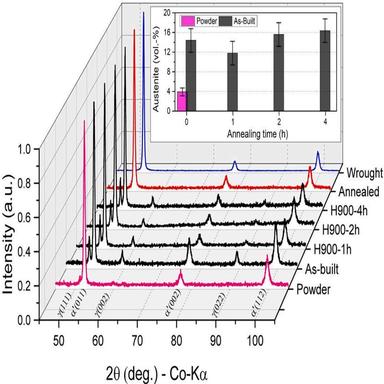
X-ray diffractograms for samples at different conditions. The amounts of retained austenite are shown in the inset. No austenite was detected for the Wrought and the Annealed conditions even after aging. H900–4 h: LPBF-processed sample aged at 482 ◦C for 4 h.